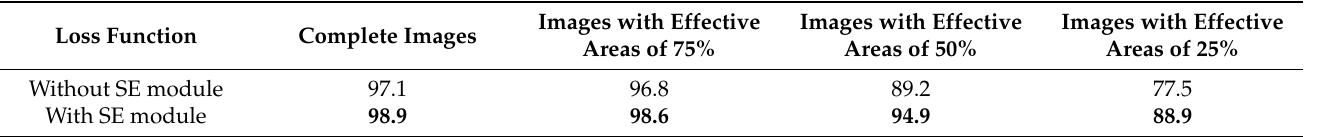
Table 2. The identification rate of the network with and without SE module (Rank-20). The best results are marked in